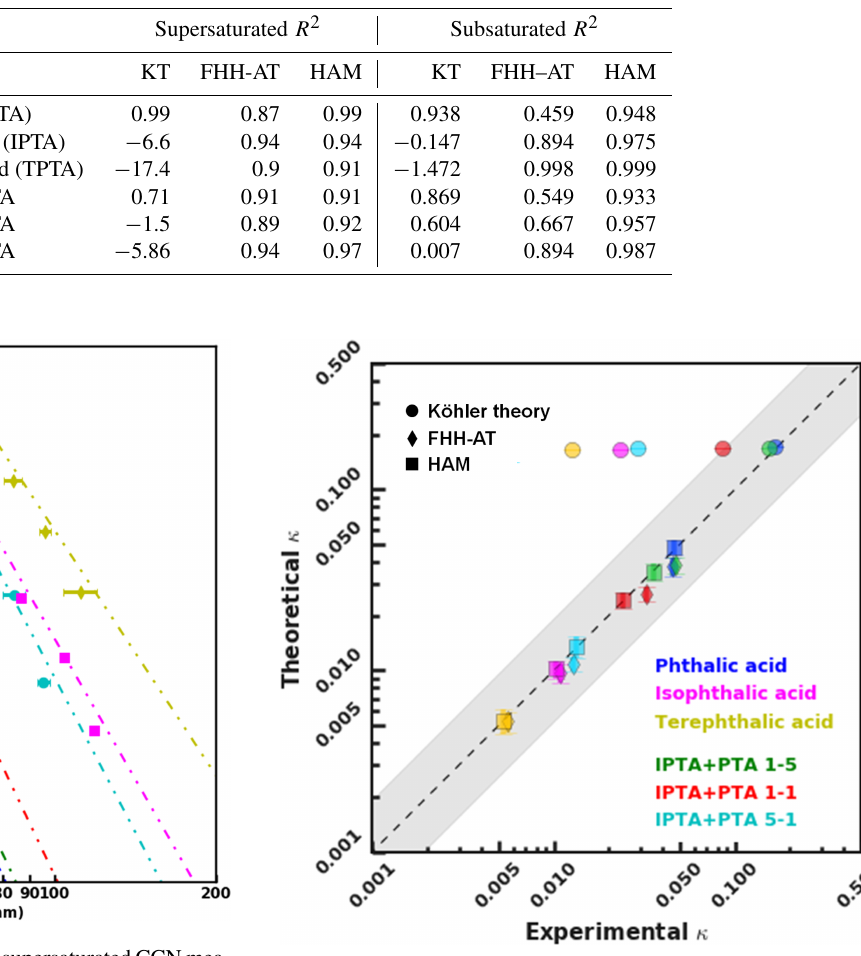
Figure 5. Closure plot representing the experimental and theoret- ical single hygroscopicity parameters obtained using KT, FHH-AT and HAM CCN analysis frameworks. The goodness of fit was cal- culated for each compound and internal